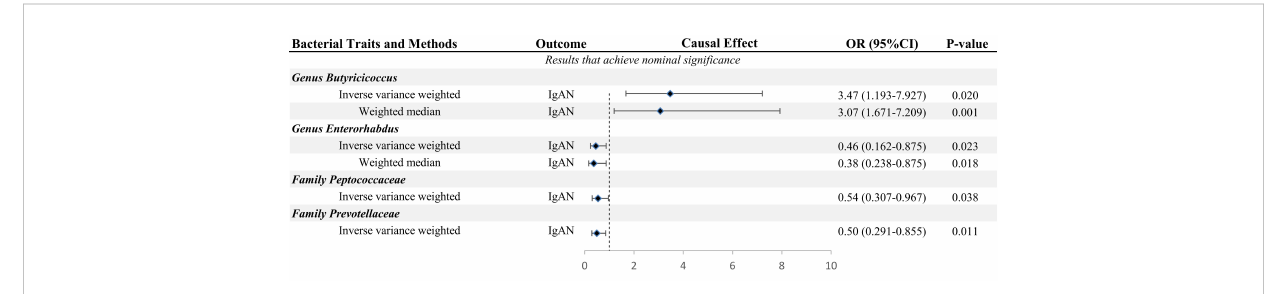
FIGURE 2 MR results of GM taxa with nominal signi fi cance causal relationships to IgAN.